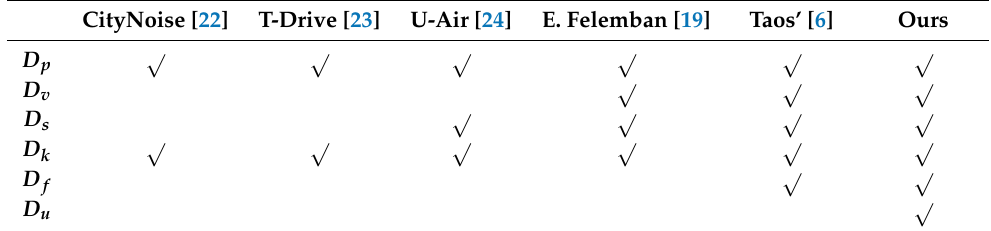
Table 1. Twin data type comparison.